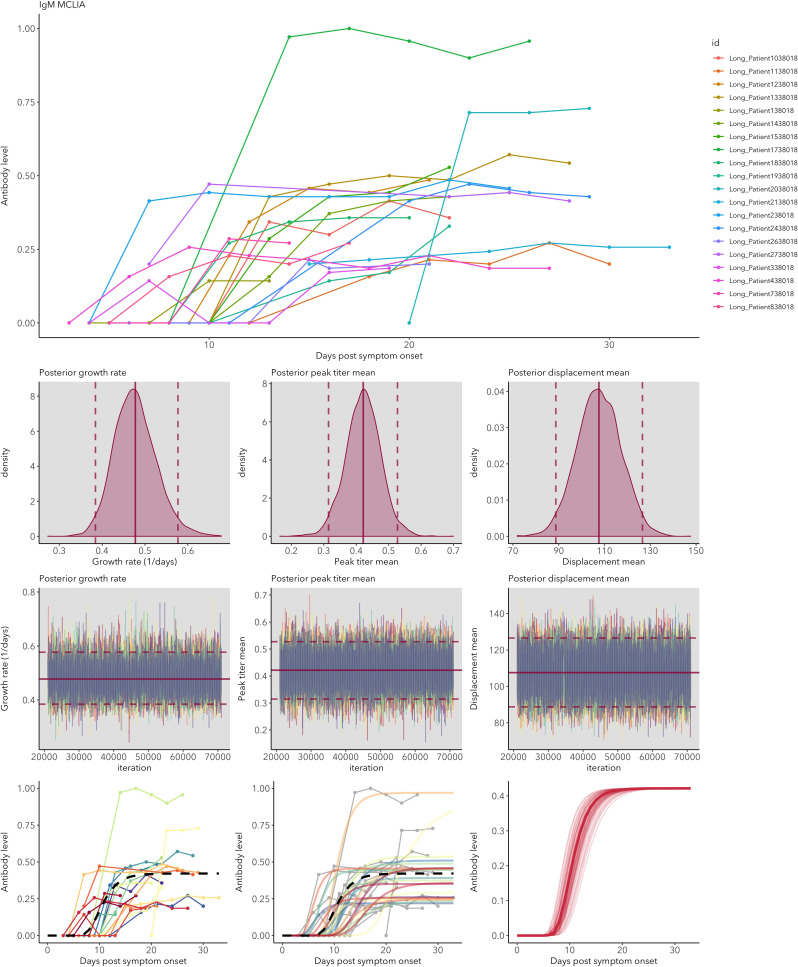
IgM MCLIA fitted antibody kinetics.